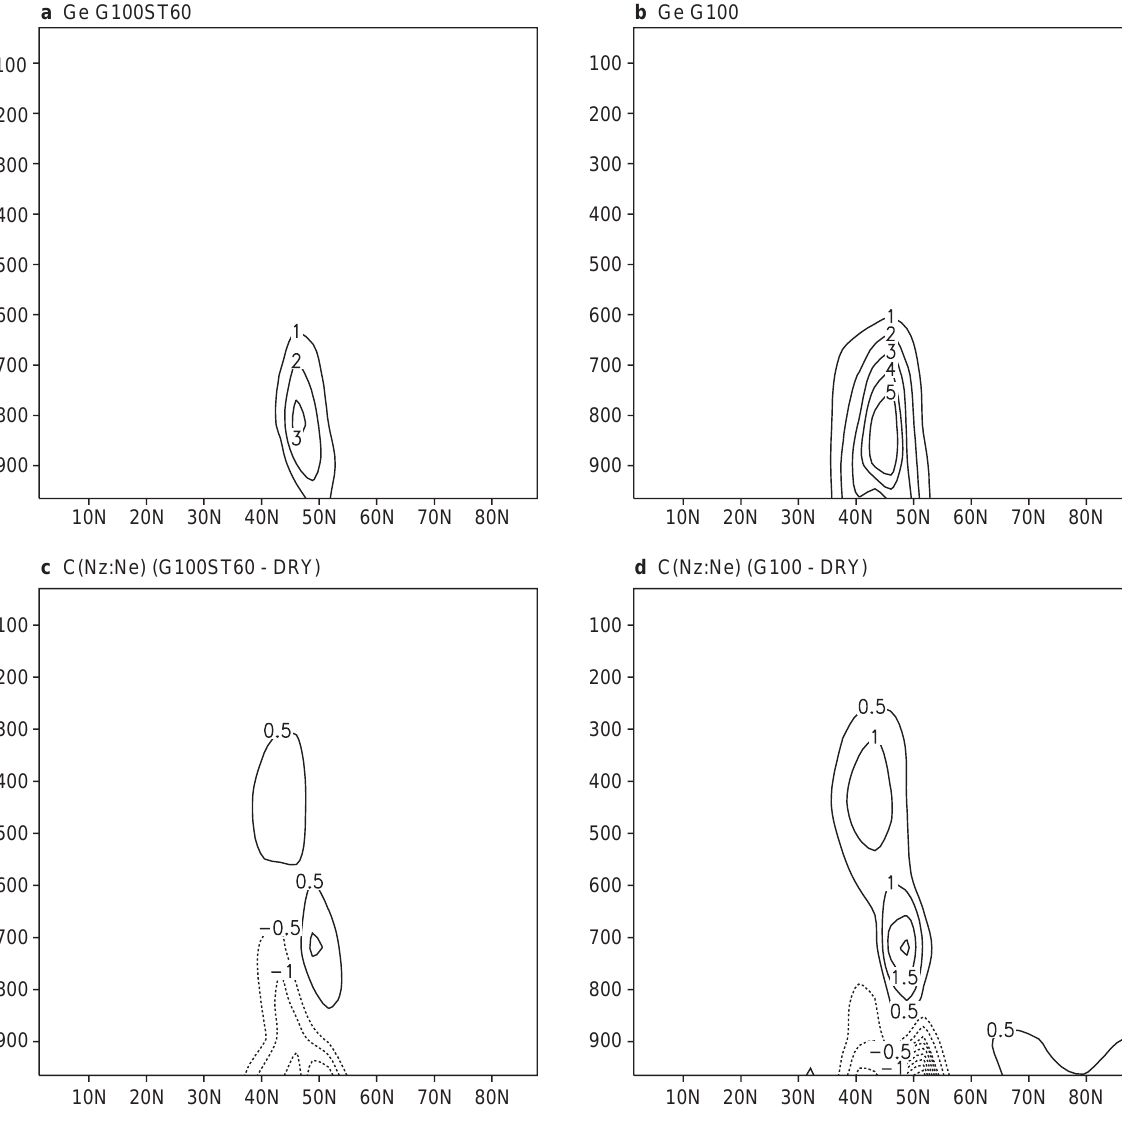
N z to N e for c the anomaly G100ST60-DRY and d the anomaly (G100-DRY). Contours every 0.5 (cid:2) 10 5 J m (cid:255) 2 per day. Zero contour omitted. Negative contours